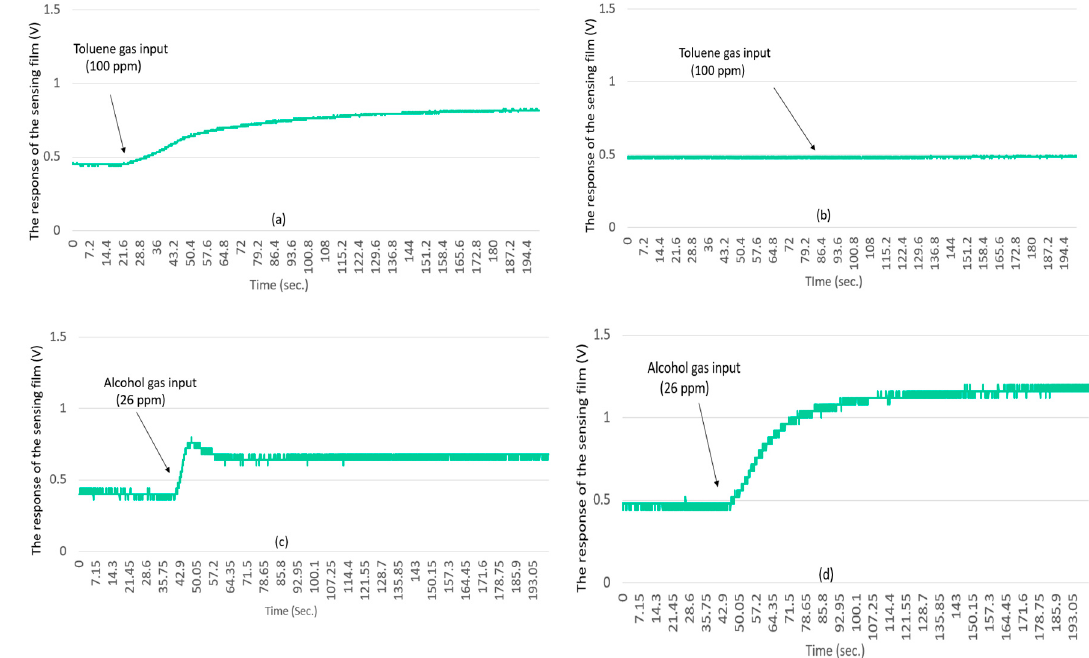
Figure 11. Resistance of gas-sensor film for ( a ) proposed driving method applying 34 mW to the microheater and injecting 100 ppm toluene; ( b ) proposed driving method applying 26 mW to the microheater and injecting 100 ppm toluene; ( c ) proposed driving method applying 34 mW to the microheater and injecting 26 ppm alcohol; ( d ) proposed driving method applying 26 mW to the microheater and injecting 26 ppm alcohol.